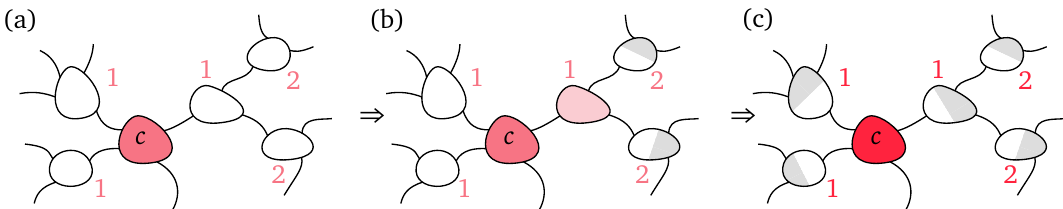
Figure 26: Example for a loop-free TN gauging procedure. The numbers indicate the distance of each node from the center c , determining the order of isometriza- tion: Starting from the un-isometrized network (a), tensors with largest distance are isometrized first, and the next tensor towards the center is updated (b). Then the isometrization continues on the next level (c). This procedure is repeated until the center (red) is